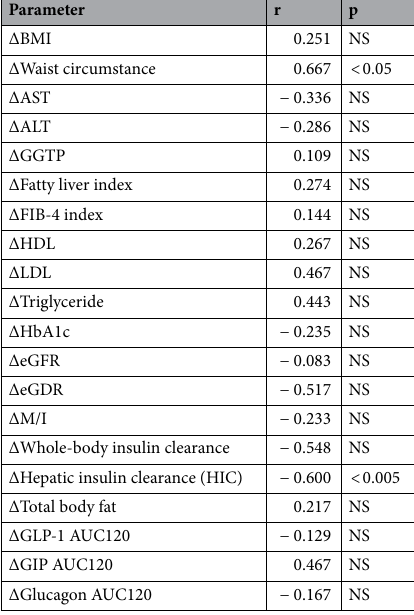
Table 2. Correlation coefficients between ΔHOMA-IR and clinical parameters. Correlation coefficients were determined using the Spearman product-moment correlation analysis. ALT alanine aminotransferase, AST aspartate aminotransferase, AUC area under the curve, BMI body mass index, CPI C-peptide index, eGFR estimated glomerular filtration rate, GDR glucose disposal rate, GIP glucose-dependent